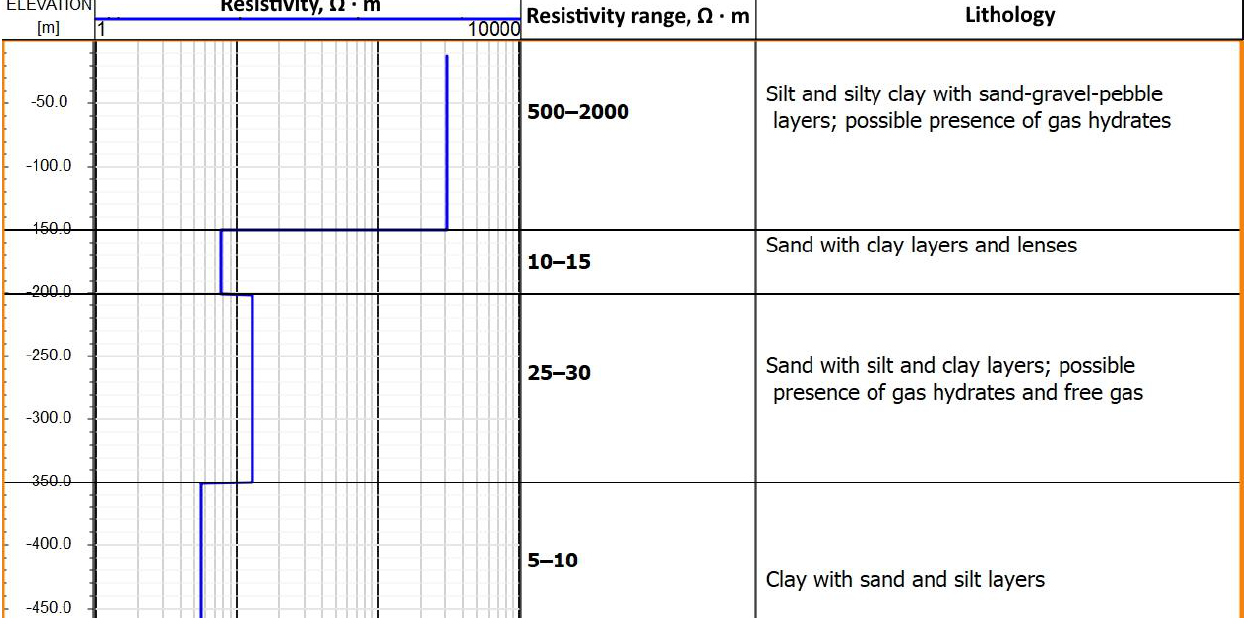
Figure 4. Generalized resistivity – geological model of shallow subsurface in Arctic West Siberia.